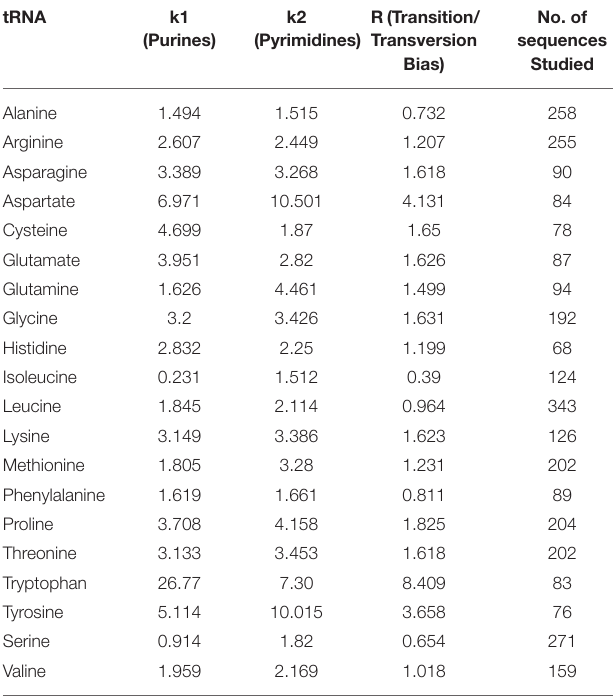
TABLE 5 | Duplication, conditional duplication, and losses of cyanobacterial tRNAs.